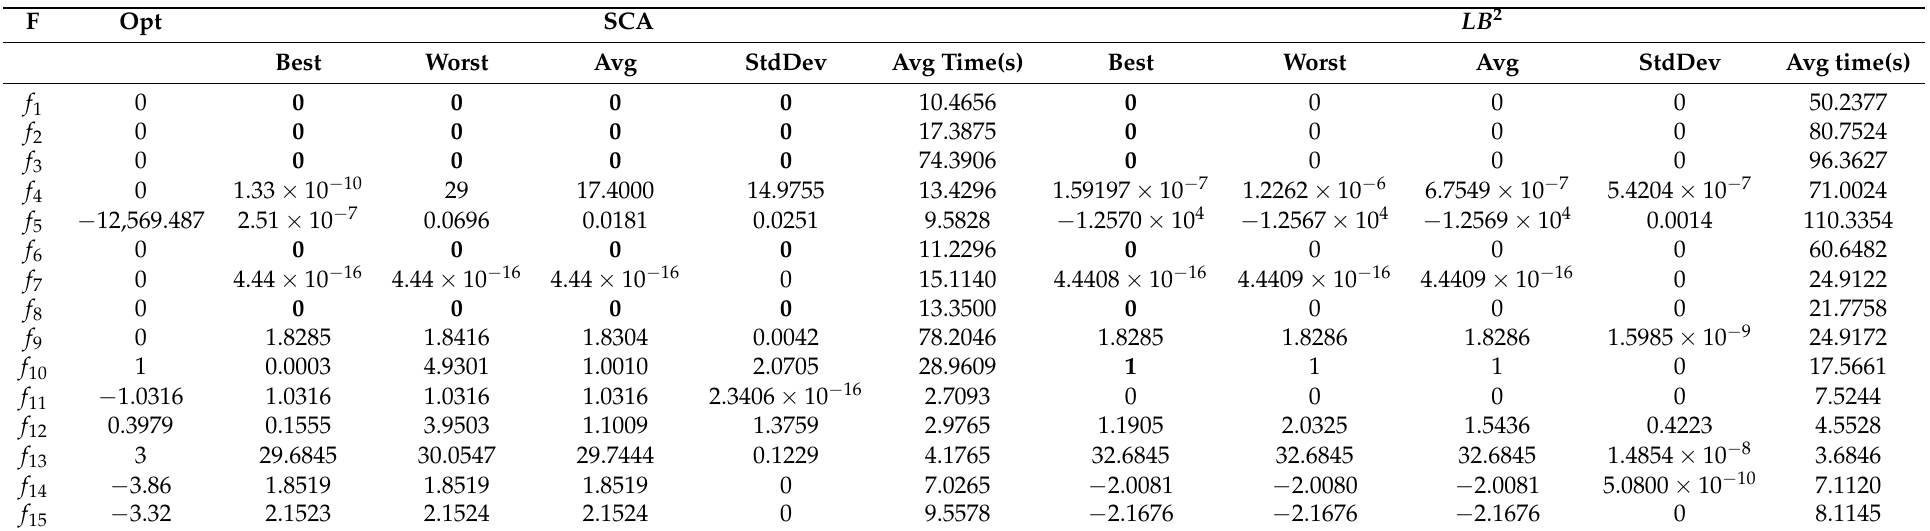
Table 12. Results comparison of SCA vs. LB 2